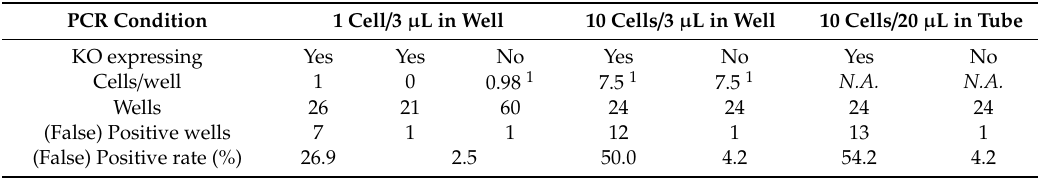
Table 1. Summary of the PCR results.